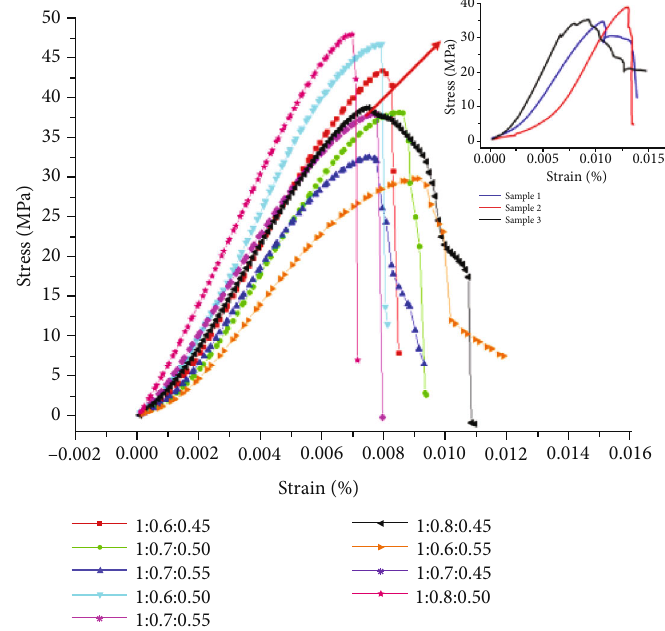
Figure 4: Stress-strain curve of the proportioned